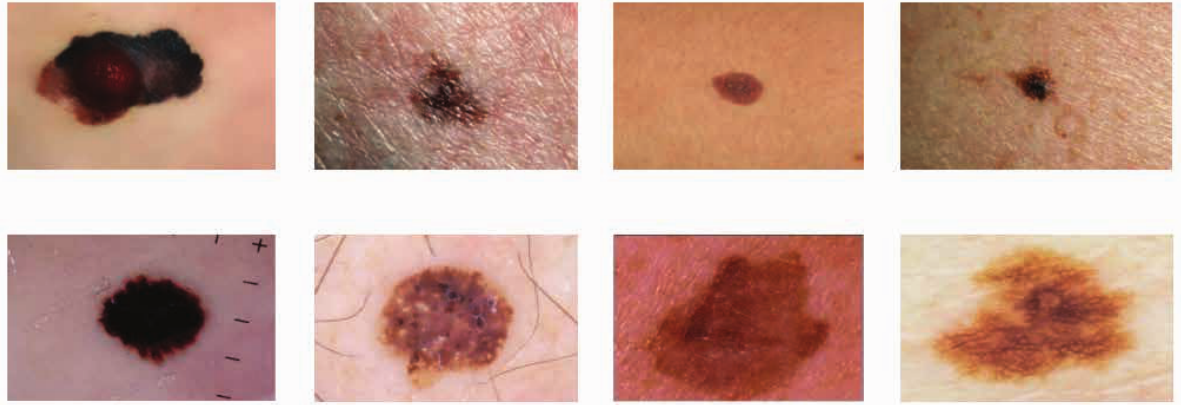
Figure 4: Some examples of the DermIS and the Dermquest databases